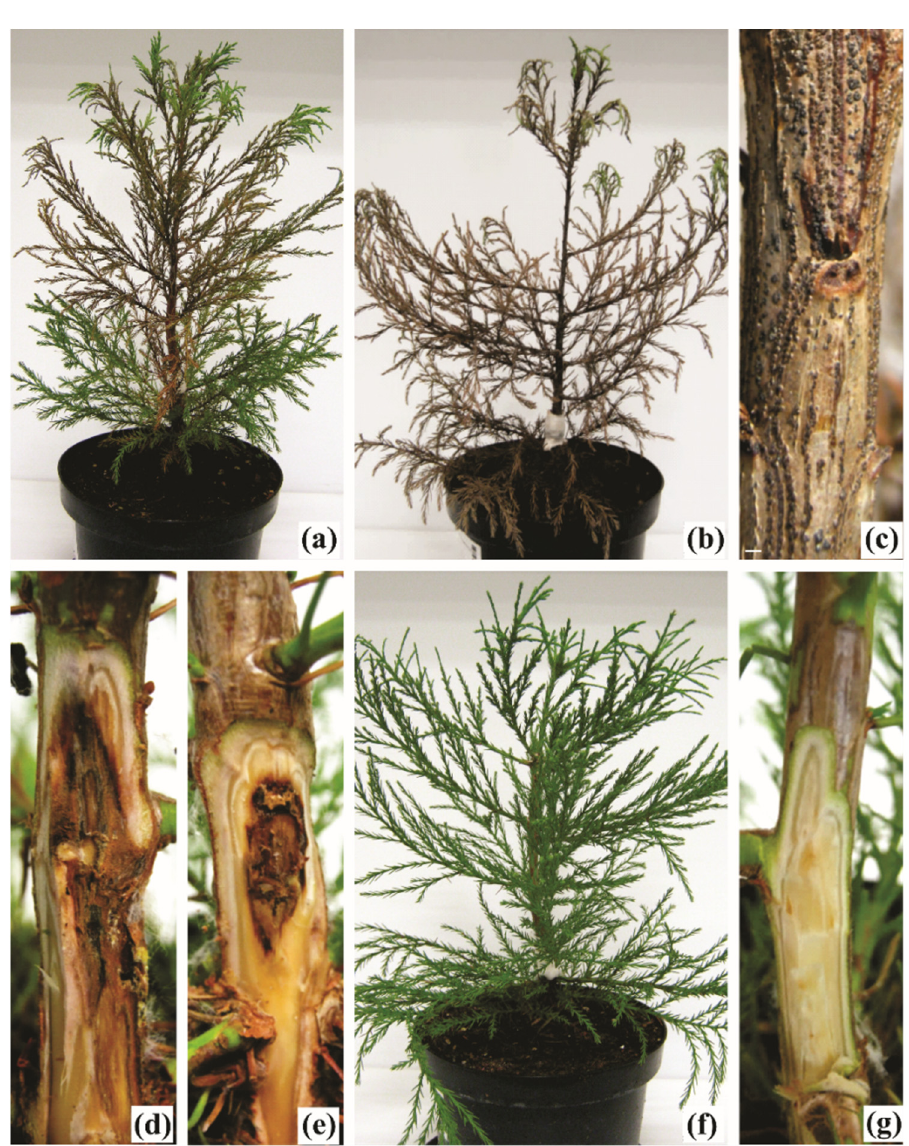
Figure 4. Disease symptoms and signs associated with Neofusicoccum yunnanense and Botryosphaeria dothidea on inoculated Sequoiadendron giganteum seedlings. ( a , b ). Browning and drying of the needles from inoculation point upwards after inoculation with N. yunnanense ILFE 5 ( a ) and ILFE 4 ( b ). ( c ). Pycnidia of N. yunnanense formed in the cankered tissue after inoculation with N. yunnanense ILFE 4. ( d ). Girdling, resin-soaked canker formed after inoculation with N. yunnanense ILFE 5. ( e ). Resinous canker formed after inoculation with B. dothidea ILFE 2. ( f , g ). Control seedling inoculated with sterile MEA plug showing no disease symptoms. Scale bar: 5 mm ( c ).